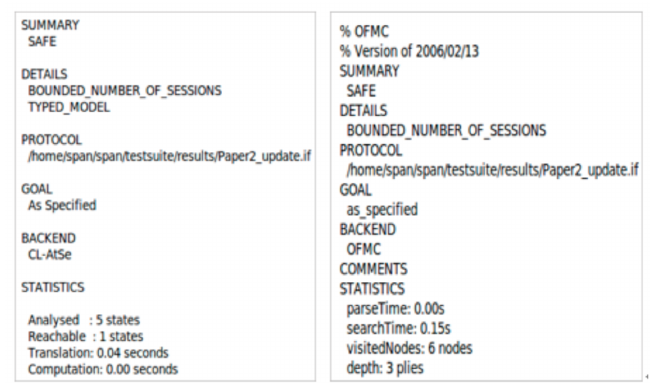
Figure 7. Role specification for